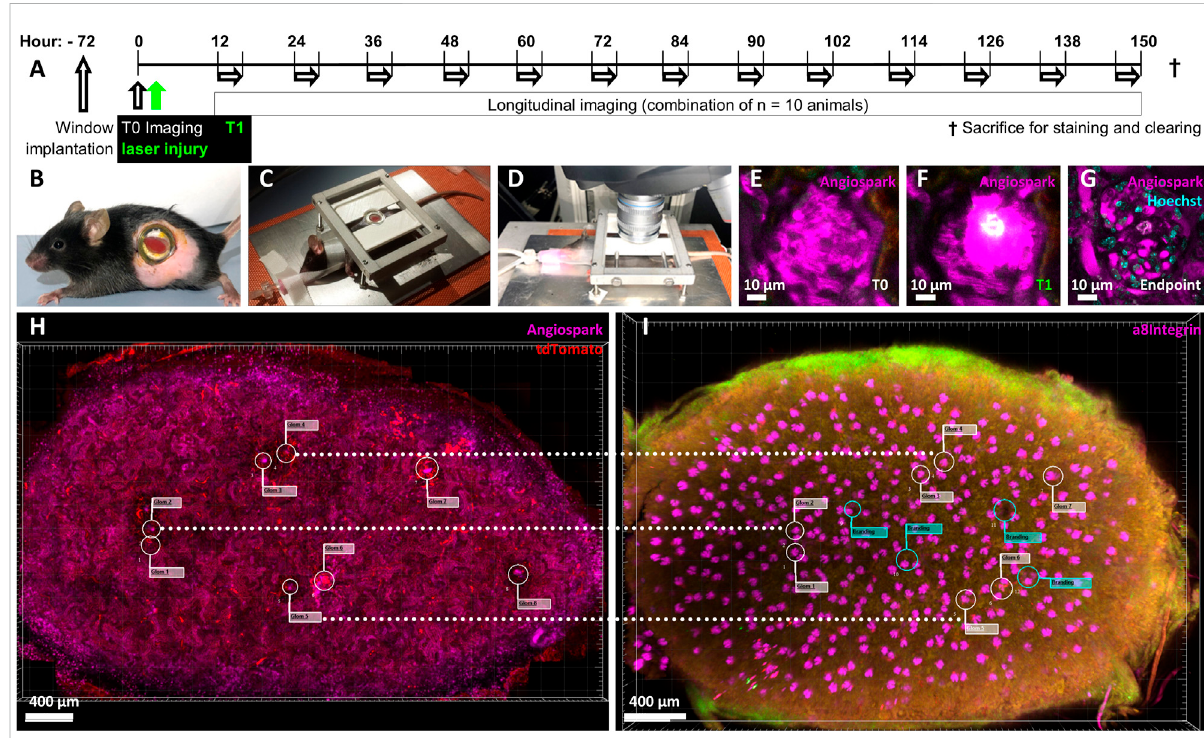
FIGURE 1 Experimental overview. Ten mRen-rtTAm2/LC-1/tdT mice underwent a 21-day pulse labelling induction period with 625 mg/kg Doxycycline and 10 mg/kg enalapril, followed by a 7-day washout period. (A) Timeline of experimental setup after pulse induction, washout and with abdominal imagingwindowimplantation72 hbeforebaselineimaging(T0)followedbyimmediatelaserinjuryirradiation(T1).Longitudinalimagingexperiments from all mice were combined and overlapped to cover the entire time period according to the scheme. Each single mouse was imaged longitudinal for 3 h, alwayswith at least 12 hrecoverytime and only to a maximum of 3times. (B) Mouse with implanted abdominal imaging window inleft fl ankandvisiblekidney(red)gluedtotheinsideofthewindow. (C) Intubated,ventilatedandanesthetizedmouseonaheatingplate fi xedviathe abdominal imaging window, (D) mounted for intravital two-photon microscopy. (E) Intravital imaged healthy glomerulus and its capillary structures made visible via (I) v . Angiospark 680 (magenta). (F) Laser-induced injury of the identical glomerulus with Angiospark 680 leakage and white auto fl uorescence of the laser-injured area. (G) Follow-up of the same laser-irradiated glomerulus 5 days after injury. The auto fl uorescent area is further visible in the still-functioning glomerulus revealed by Hoechst nuclear staining. (H) Kidney overview of glomeruli positions in three- dimensionalintravitalimagingdataand (I) alignmenttoidenticalglomeruliaftersacri fi ce,immunohistologystainingandtissueclearing.Guidinglaser brandings are marked with green fl ags in the